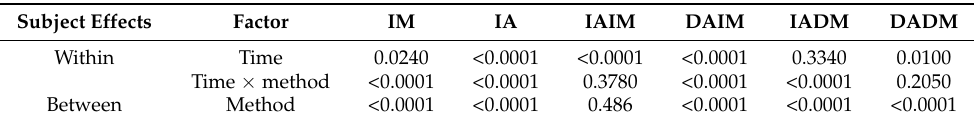
Table 4. Main model of the GLM repeated measurement analysis for factors affecting evolution of sperm quality variables over time using frozen/thawed bull semen ( n = 14).